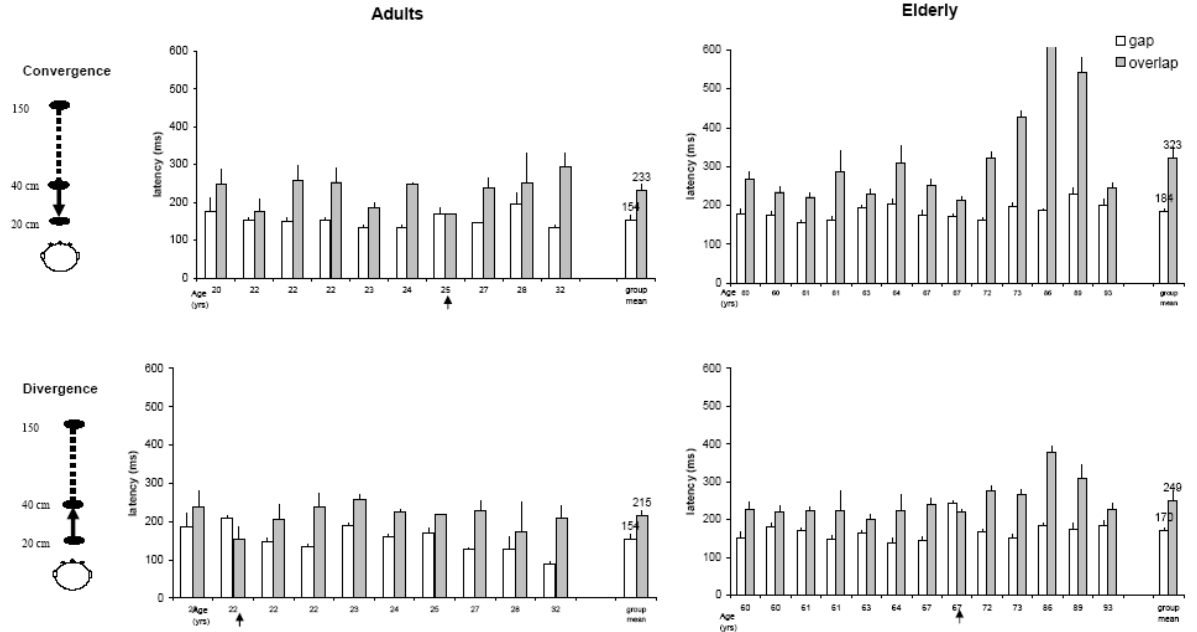
Figure 2. Individual and group mean latency with standard errors for convergence or divergence starting from near fixation point (two LEDs at 20 cm and 40 cm in front of subject, respectively) in the gap and the overlap conditions for both young and elderly subjects.